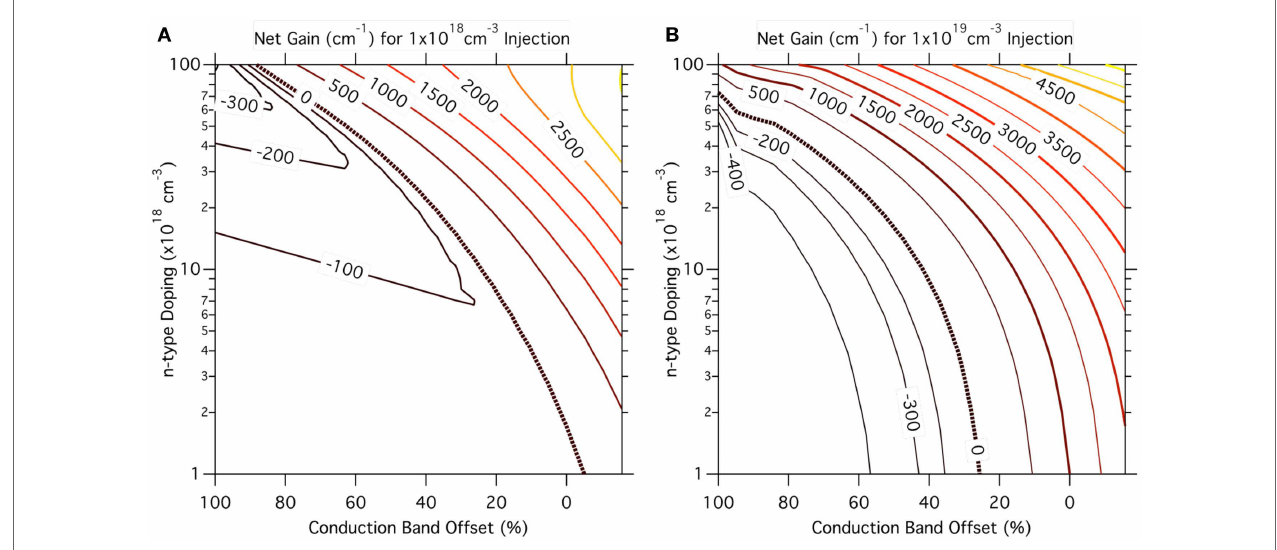
parameters. The map is calculated for a carrier injection of (A) 1 × 10 18 cm − 3 and (B) 1 × 10 19 cm − 3 . The black, broken line depicts the transparency condition when the gain equals the losses.